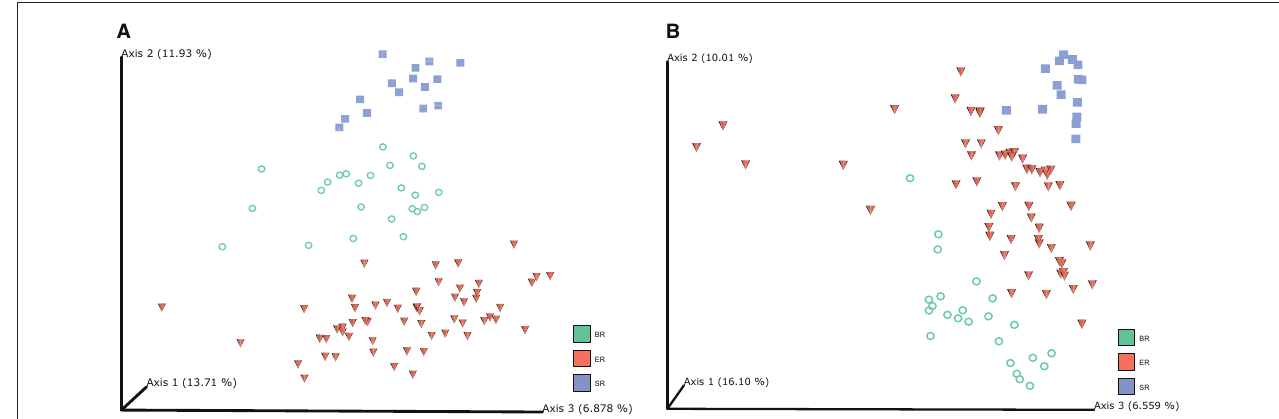
FIGURE 2 | Microbiome clustering of different groups of monkeys. Principal coordinate analysis (PCoA) 3D-plots display bacterial community structure based on unweighted UniFrac distance (A) and Bray-Curtis distance (B) . The numbers of Axis 1, Axis 2 and Axis 3 showed the percent variation explained by the PCoA plots, indicating three distinctive clusters of microbiome